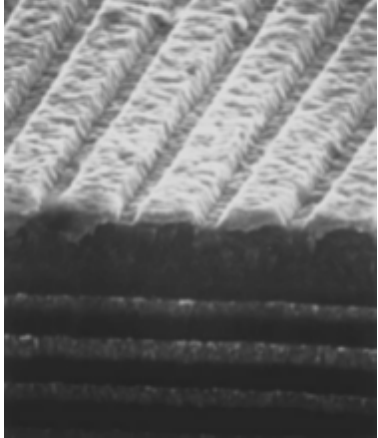
Figure 6. Cross ‐ sectional SEM image of the 1550 gr/mm grating.